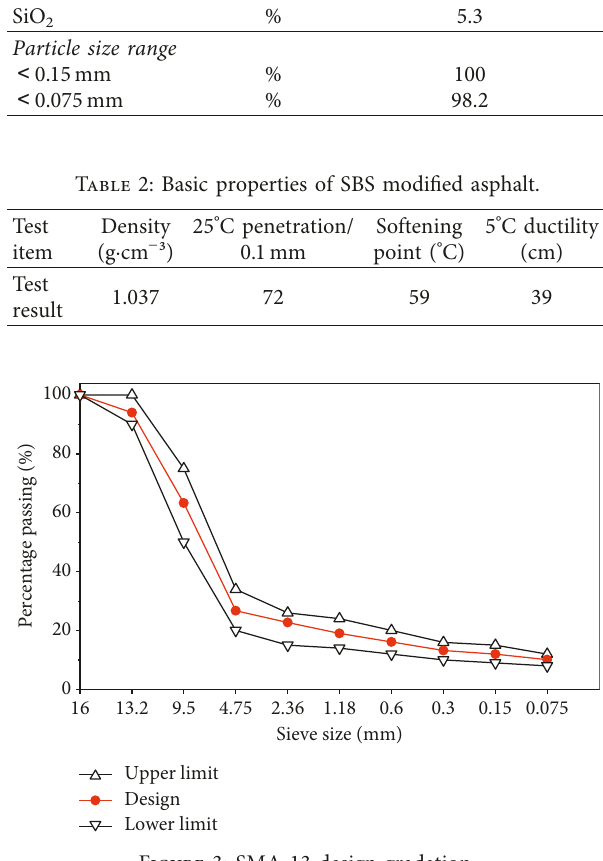
Figure 3: SMA-13 design gradation.